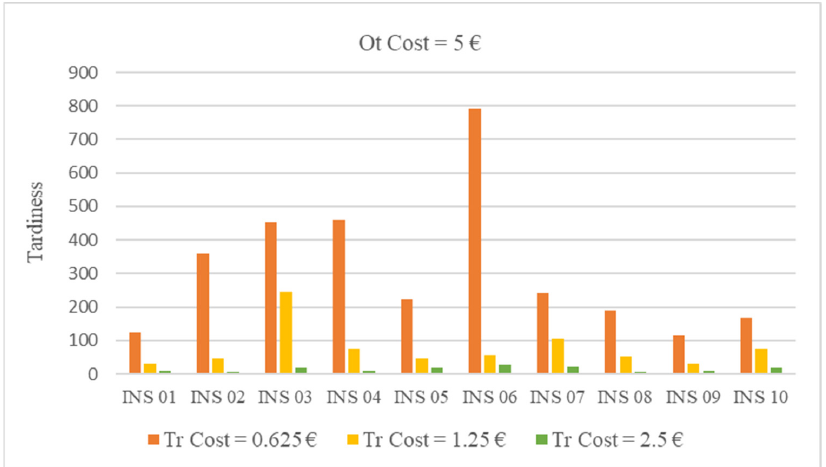
Figure 9. The amount of imposed “Tardiness” with respect to various tardiness penalties.